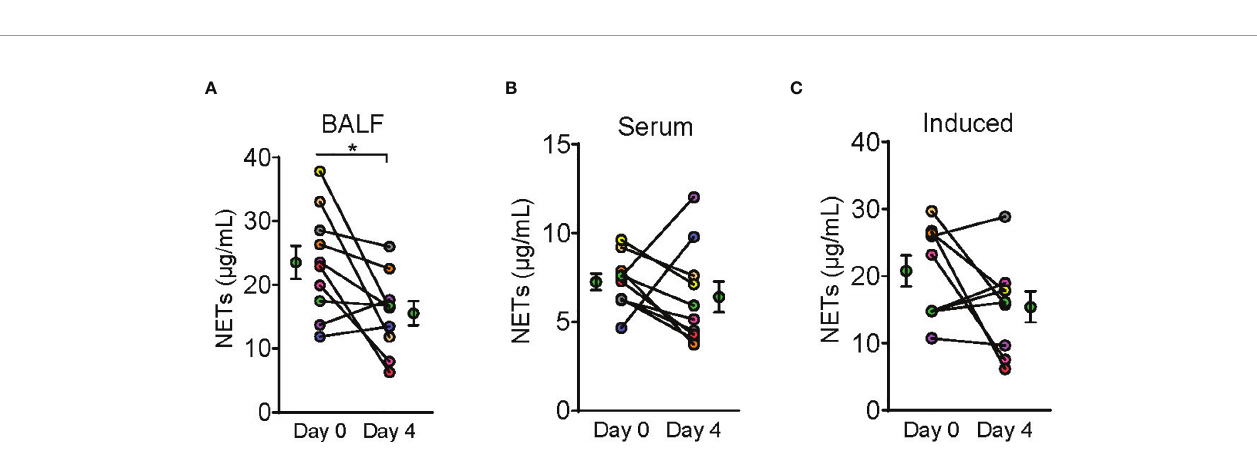
FIGURE 4 | Dornase alfa treatment reduced BALF NETs. Symbols on Day 0 and Day 4 are represented as mean ± SEM of 10 subjects in the bronchoalveolar fl uid (BALF) analysis and serum neutrophil extracellular traps (NETs) analysis and 9 subjects in the induced NETs analysis. Due to not having the appropriate material prior to sample collection from the fi rst enrolled patient, we were only able to perform induced NET analysis on 9 subjects (C) . Each connecting line with points at Day 0 and 4 represents a unique patient sample and is patient colored coded to previous graphs (N=10). NETs de fi ned by NET MPO : DNA complex measurement was signi fi cantly reduced in the BALF after 3 days of therapy with dornase alfa (A) . There was no signi fi cant change in serum NETs or NETs induced in vitro from patient neutrophils harvested after dornase alfa therapy (B, C)